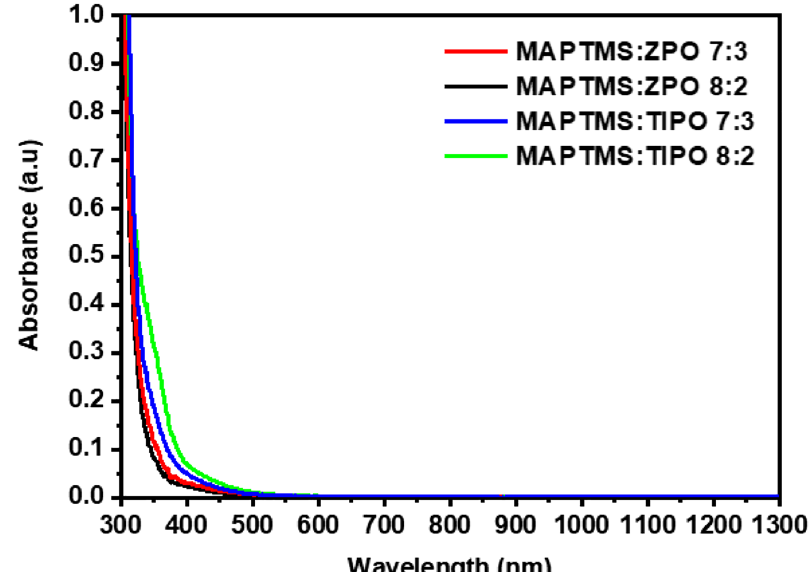
Figure 1: Absorption spectra of the ZPO and TIPOhybrid photoresists. The redand black line corresponds to the MAPTMS : ZPO 7 : 3 and 8 : 2 molar ratio material, respectively, while the blue and green line corresponds to the MAPTMS : TIPO 7 : 3 and 8 : 2 molar ratio,